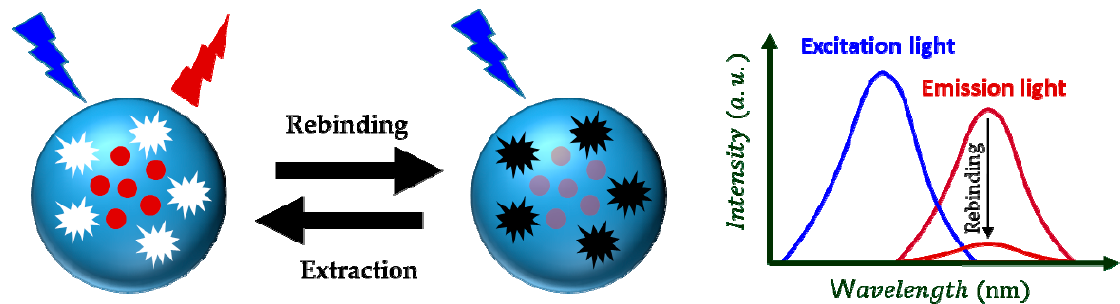
Figure 3. The basic working principle of the most MIP-based fluorescence sensors. Various fluorophores were used to develop MIP-modified fluorescence sensors in- cluding quantum dots (QDs), fluorescent organic molecules within the polymer matrix or the target molecule itself. In order to make a sensitive fluorescence-based MIP-modified sensor, the background noises must be mitigated. This was evaluated by a Monte Carlo model using anthracene-imprinted polyurethane films having various thicknesses [106]. Developed model suggests that the imprinted polymers would need to have reduced absorption coefficients or to have a quantum yields much lower than that of the analyte at the detection wavelength. In another study, fluorescence lifetimes and anisotropies were evaluated to distinguish between the analyte and the imprinted polymers when their fluorescence spectra overlap [107].